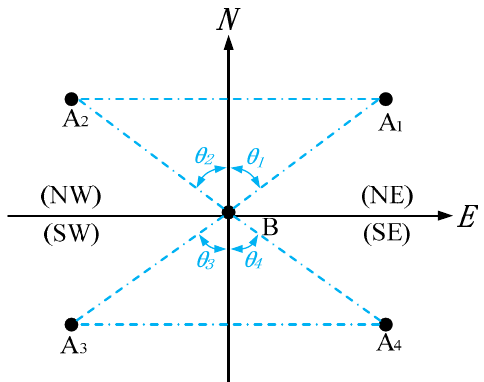
Figure 4. Relative position of site A and B.